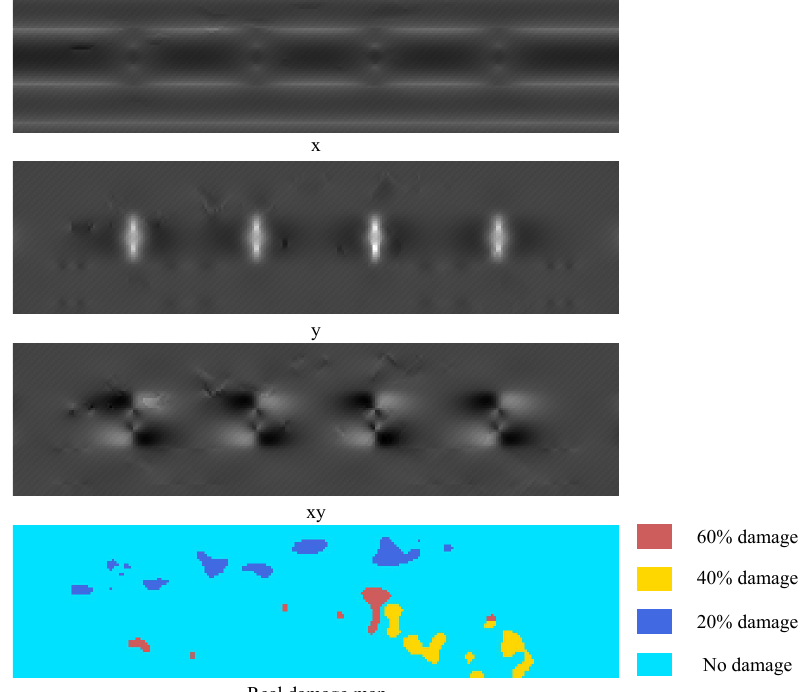
Figure 8. Example of sleeper beam